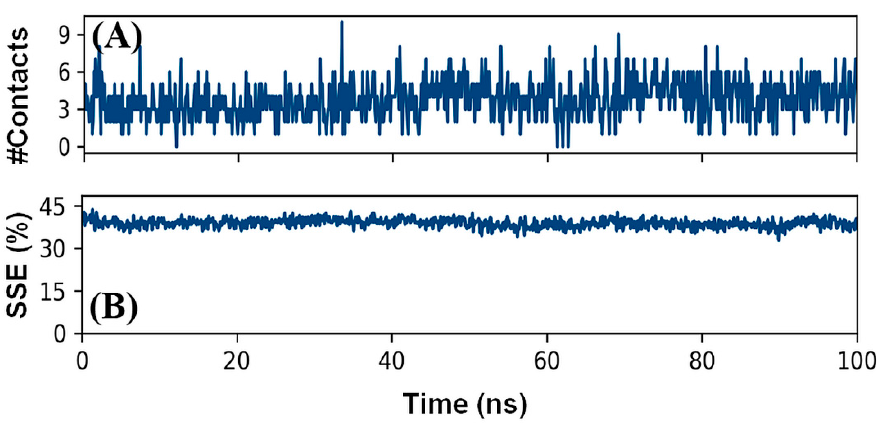
Figure 7. ( A ) Total number of contacts formed between geraniol and AChE; ( B ) total secondary structural elements (SSE) of AChE in combination with geraniol.